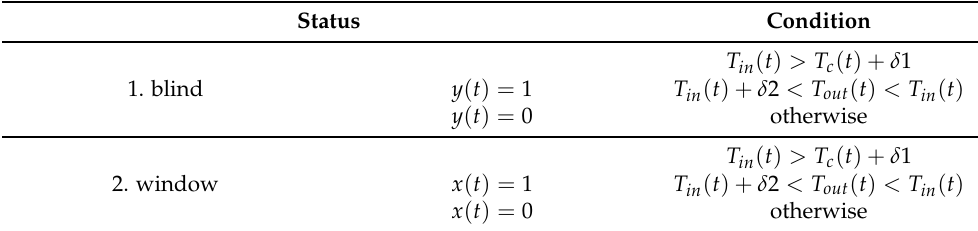
Table 4. Control logics of window and blind by BEMS if no occupancy is